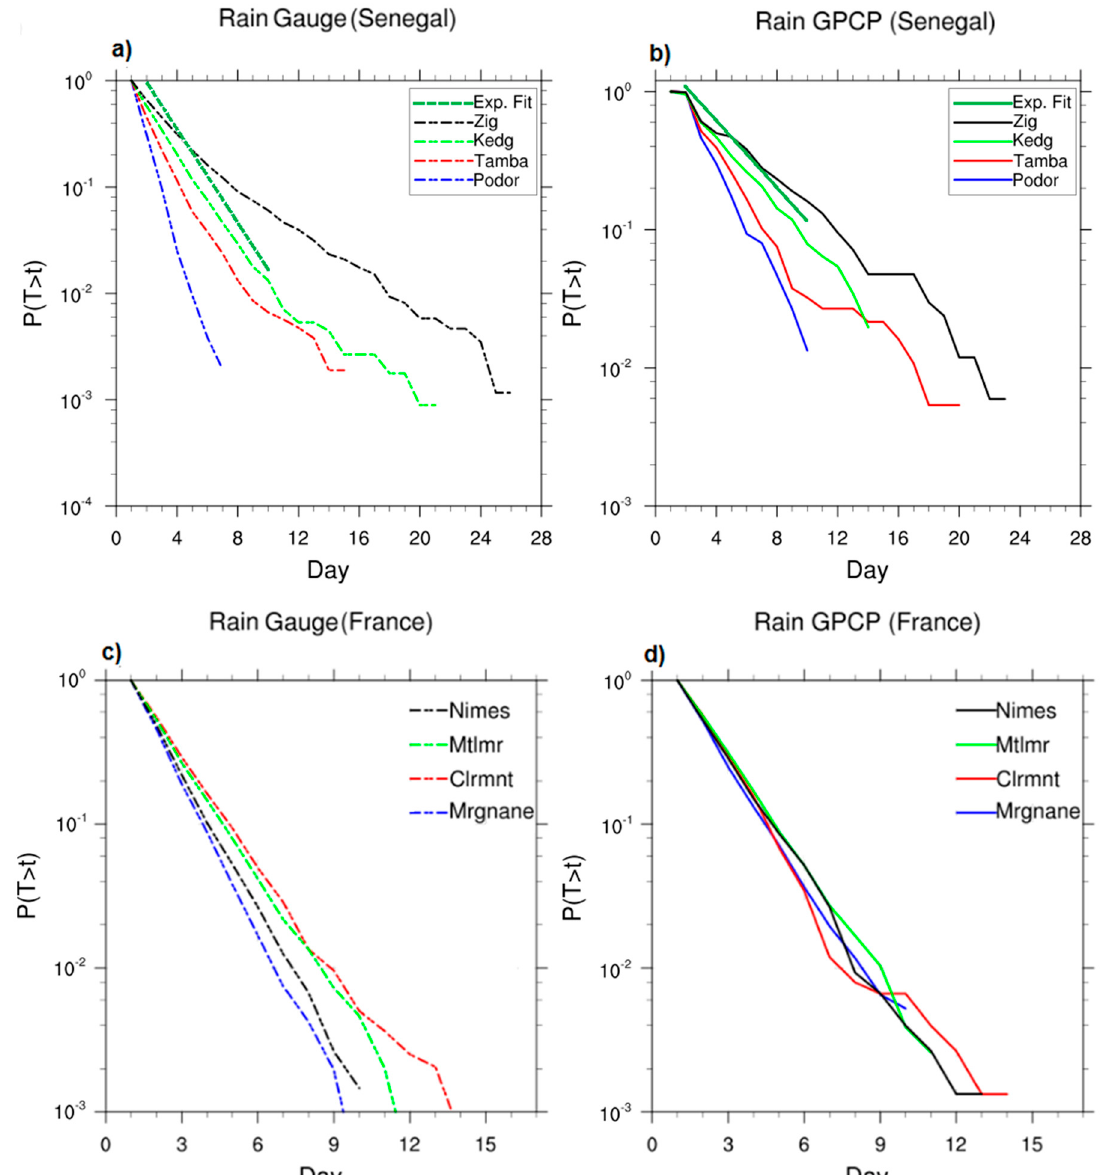
Figure 4. Probability rainy day occurrence in a log-lin plot ( a ) at four sites (Podor, Tambacounda Ziguinchor and Kedougou) in Senegal (Sahel) with daily observation data (rain gauge 1966–2007). ( b ) at the nearest pixels of the four sites (Podor, Tambacounda Ziguinchor, and Kedougou) of Senegal (Sahel) with daily GPCP data (1998–2008). ( c ) at four sites in France (Middle latitudes), Clermont (1944–2015), Montelimar (1920–2015), Nimes and Marignane (1945–2015) with daily observation data. ( d ) at the nearest pixels of the four sites (Clermont, Montelimar, Nimes, and Marignane) of France with daily GPCP data (1998–2008). An exponential fit of Kedougou based on Equation (1) is in dashed dark green ( a ) and continuous dark green ( b ).